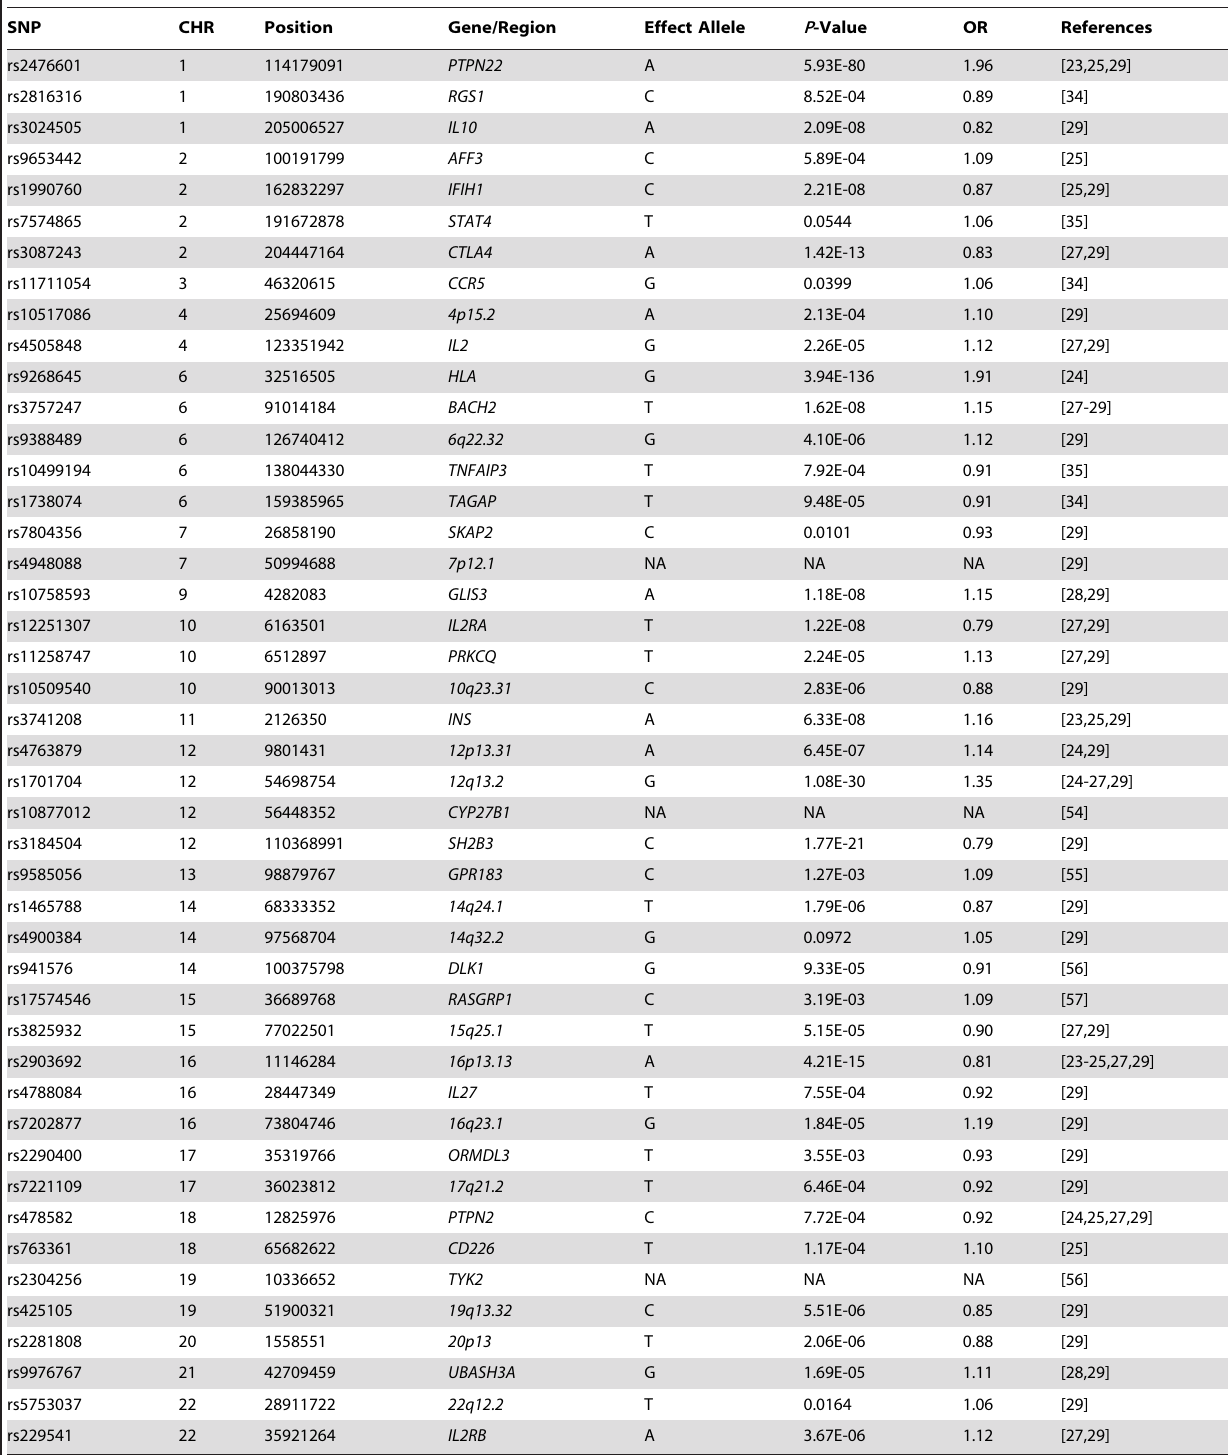
Table 2. Discovery set P -values and odd ratios are shown for known T1D associated autosomal SNPs.